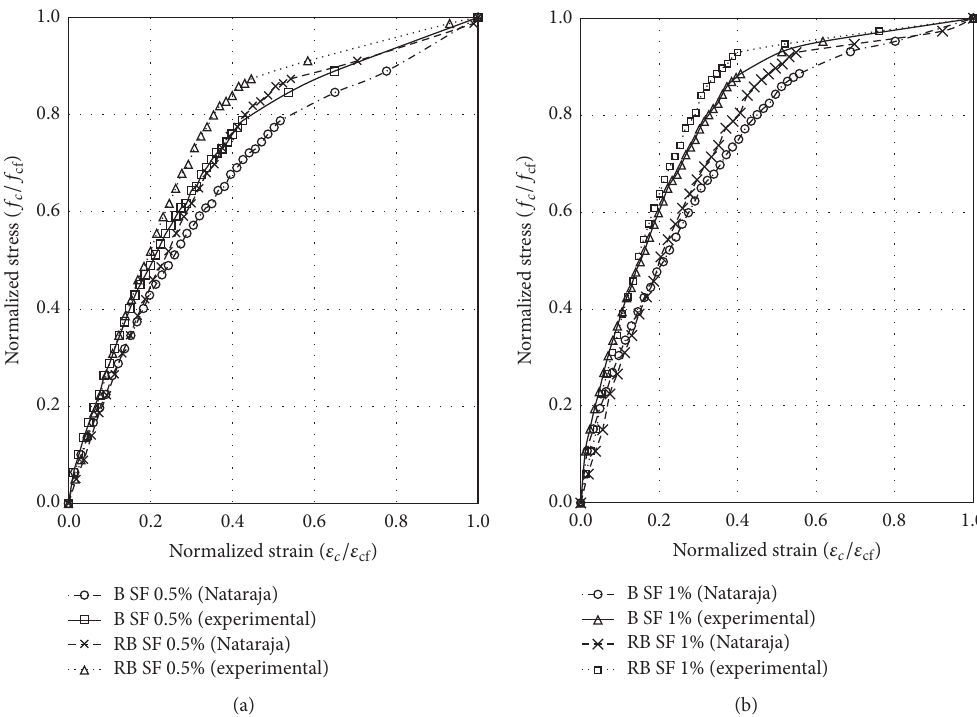
Figure 16: Normalized stress-strain diagram at 14 day; (a) 0.5% SF and (b) 1% SF.